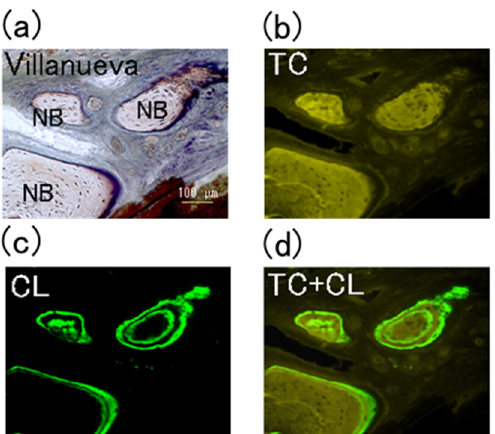
Figure 8. Double fluorescently stained images of cranial bone defect filled with P-nHAP/COL ( a ) and without implant material (DEF; ( b )) at 8 weeks after surgery. Top = contrast; second = TC, fluo- rescently labeled; third = CL, fluorescently labeled; bottom = TC + CL overlay images.